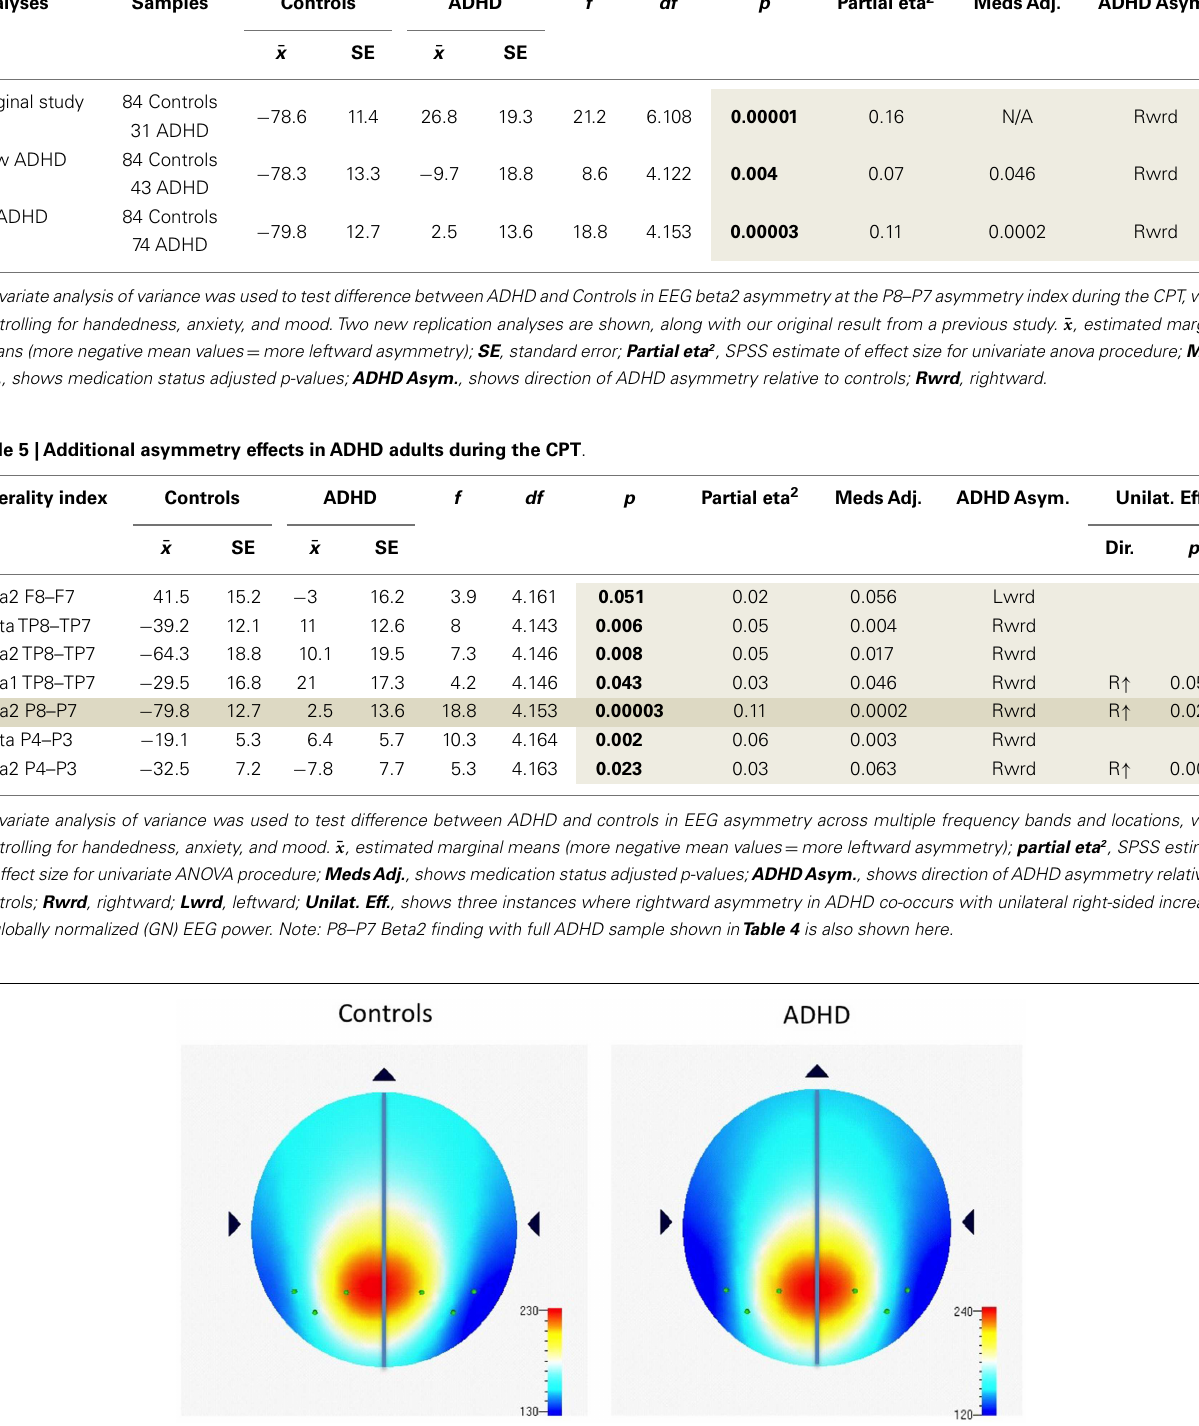
Table 4 | Replication of rightward beta2 asymmetry at the P8–P7AI in adults withADHD . Analyses